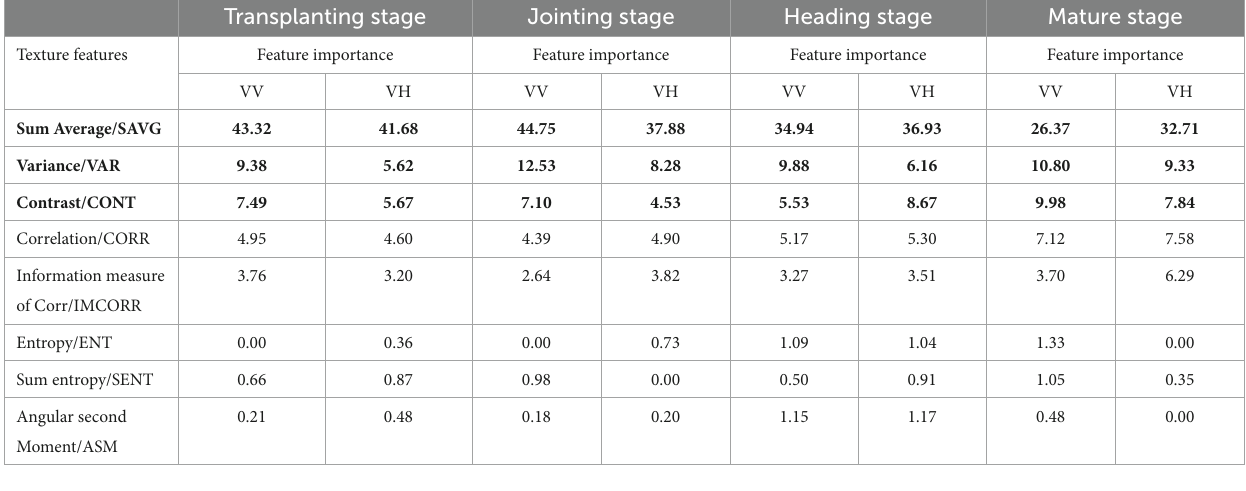
TABLE 3 Feature importance of texture features calculated by the random forest algorithm. The three texture features of highest importance were selected for this study (shown in bold).